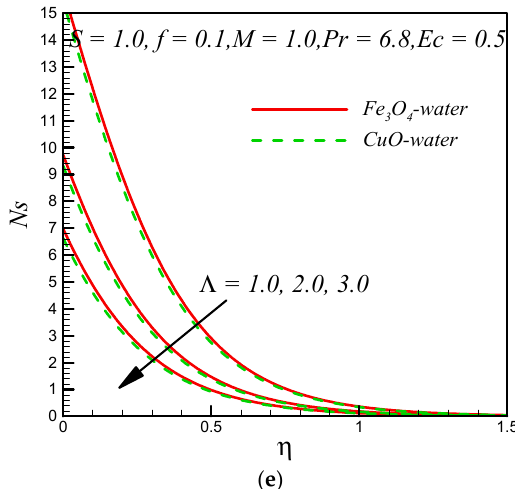
Figure 4. Variation of entropy generation profile 𝑁𝑠(𝜂) with ( a ) 𝐸𝑐 , ( b ) 𝑆, ( c ) 𝜙 , ( d ) 𝑀 , and ( e ) 𝛬 .